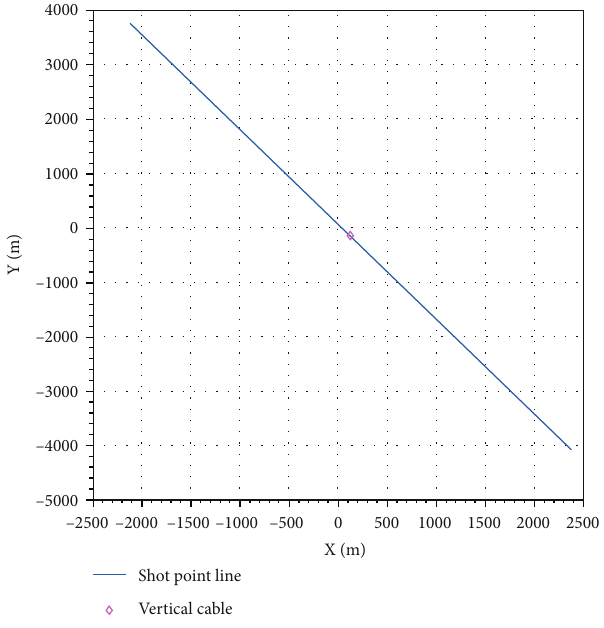
Figure 2: Location of line 39 and vertical